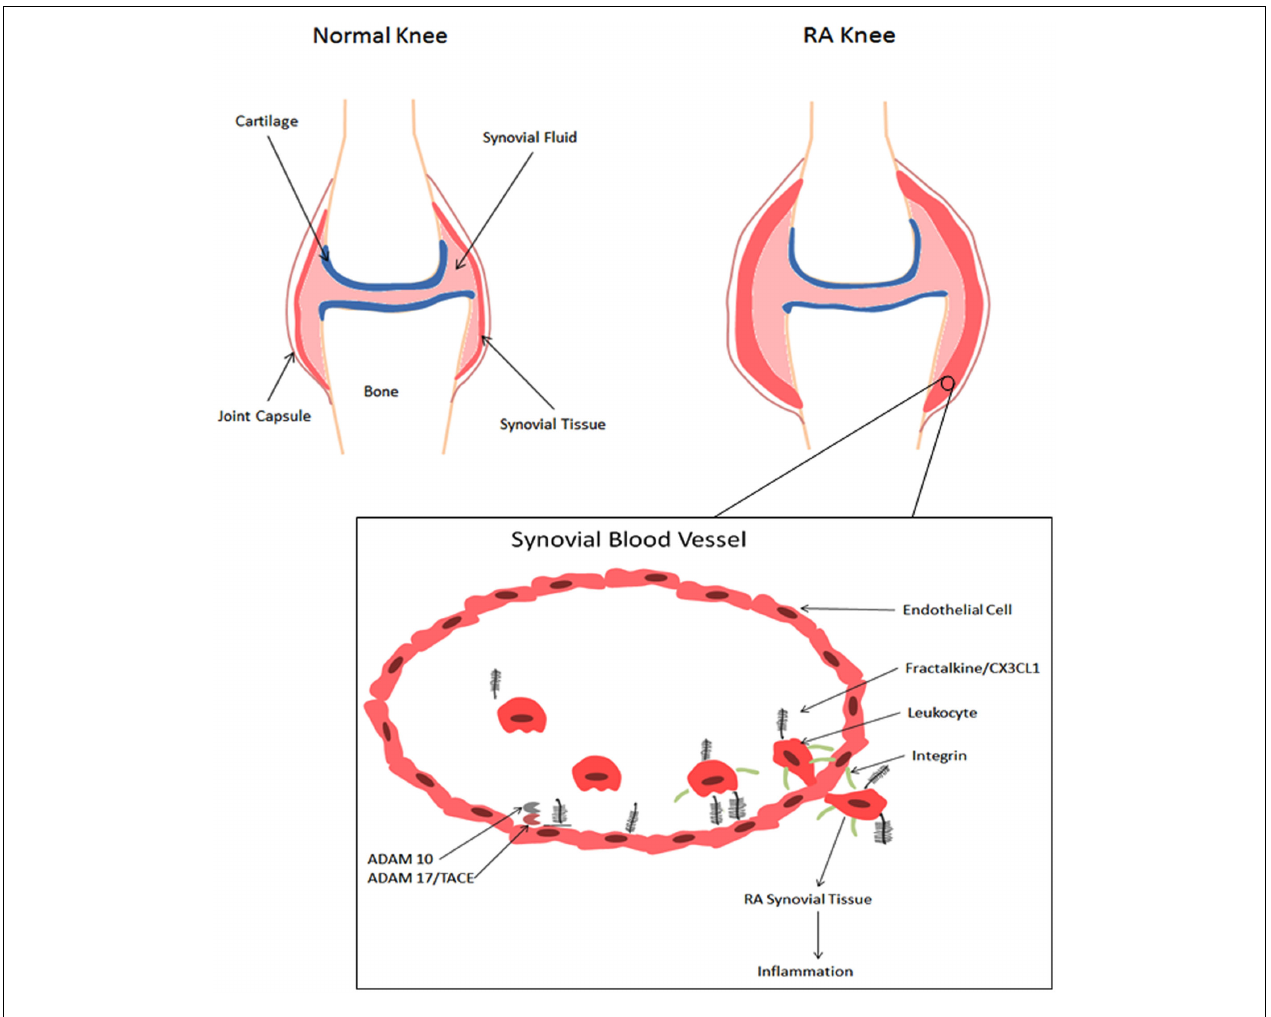
integrin affinity and leukocyte adhesion (Jones et al., 2010). Soluble fractalkine/CX3C1 binds to CX3CR1 aiding leukocyte extravasation through the vascular wall and into the tissue, further initiating the inflammatory response (Umehara et al., 2004). Membrane-bound fractalkine/CX3CL1 is cleaved by ADAM10 and ADAM17/TACE to generate soluble fractalkine/CX3CL1, which consists of the chemokine domain and